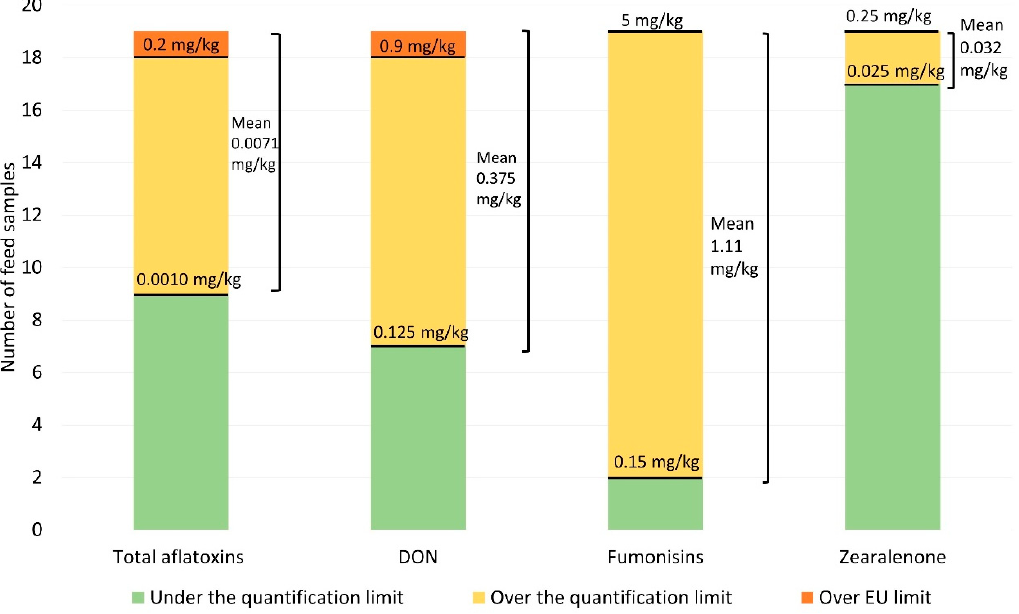
Figure 1. Frequencies of the samples of feed mixtures for sows, showing mycotoxin values above the quantification threshold (indicated as lower value per each histogram) and above the limits set by EU [10,11] (upper values), and means of values for each mycotoxin. Table 2. The concentrations of mycotoxins observed in sow colostrum sampled from the di ff erent farms using LC-MS; the samples were chosen in order to represent the range of values found in the respective in-home feed mixtures. Values represent each colostrum sample from an individual farm. LOQ = limit of quantification. All the samples from farms 3, 7, 11, 17 and 19 were negative for aflatoxins. Farm DON ( µ g / kg) Farm Fumonisins ( µ g / kg) 8.6 (signal for FB1 < LOQ) 8 < 10.0 9 no